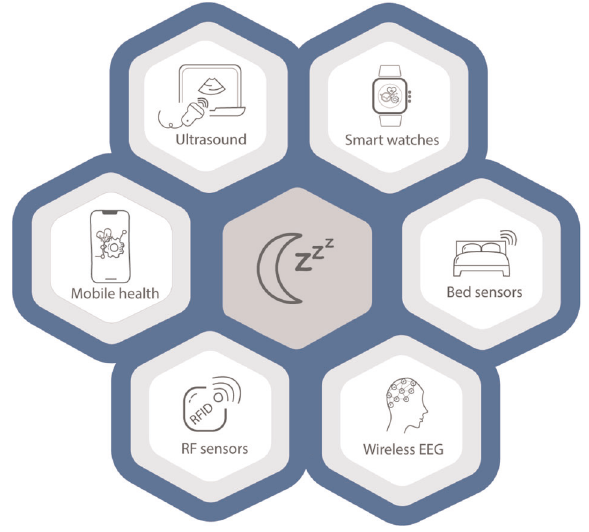
Fig. 2 Emerging sleep-sensing technologies. Emerging sleep technologies range from non-contact methods like RF sensors to miniaturized, wireless or in-ear